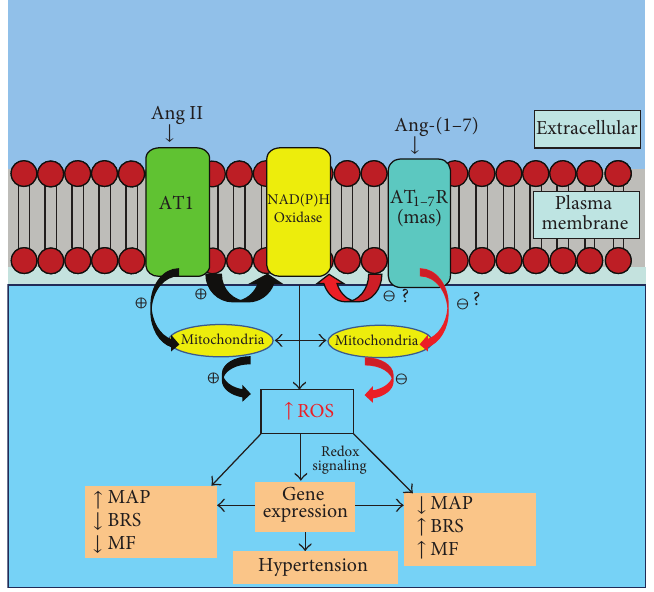
F 1: Proposed model: Ang-(1–7) through indirect (NADPH oxidase-mediated ROS) and/or direct interactions with mitochondria can attenuate ROS in dorsal medulla resulting in reduced blood pressure and enhanced barore�ex and mitochondrial function. ROS: reactive oxygen species; MAP: mean arterial pressure; BRS: barore�ex sensitivity; MF: Mitochondrial function; �: not known.